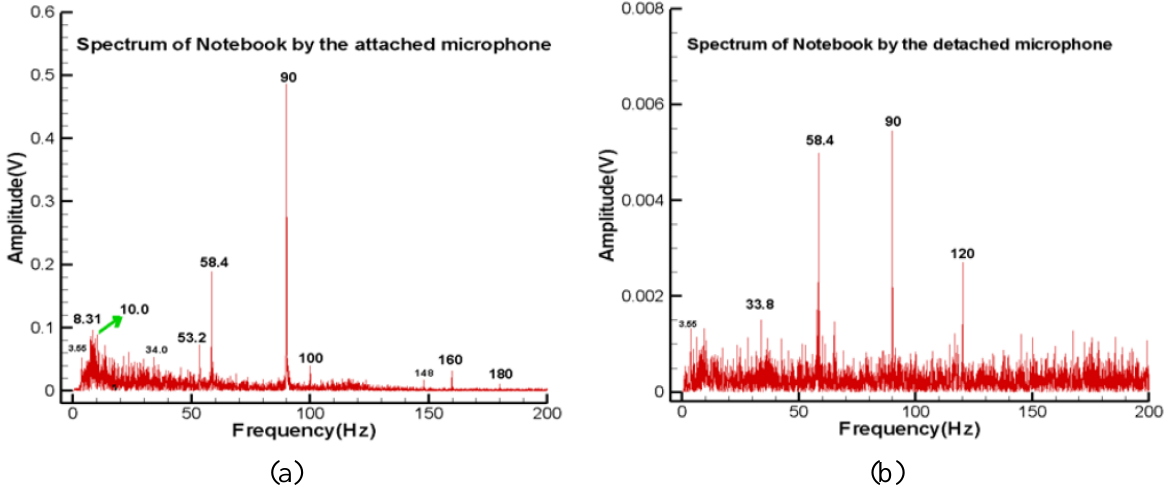
Figure 8. Spectrum of notebook computer: (a) microphone attached to the right board of touchpad. (b) microphone at 2 cm above the